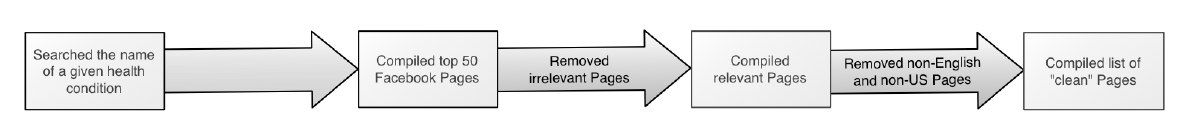
Figure 1. Search result